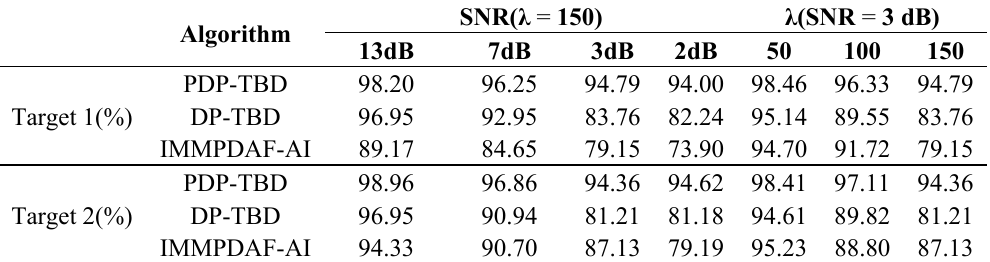
Table 1. Comparison of correct track probabilities (200 runs,